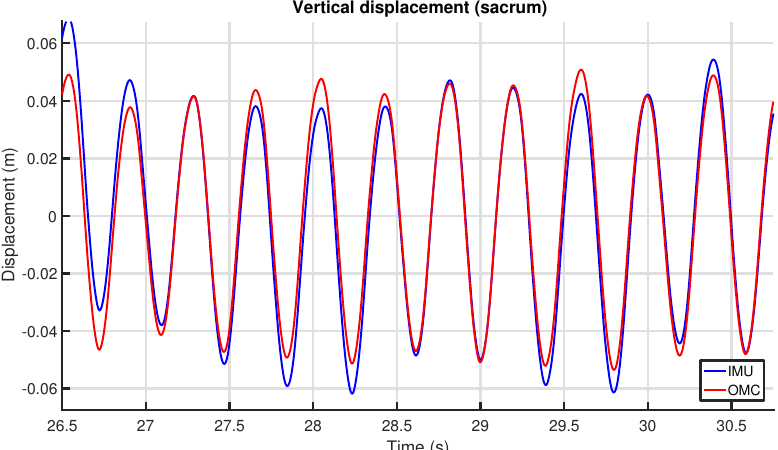
Figure 18. Example of the vertical displacement match between IMU and OMC systems for the